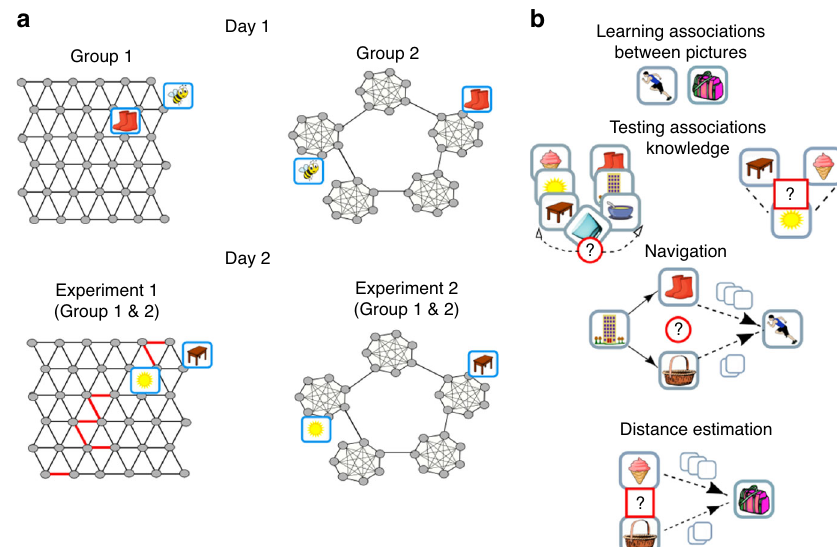
Fig. 1 Transfer of structural knowledge: graph structures and experimental design. a Experimental design. Agents and participants learned graphs with underlying Hexagonal (left) or Community (right) structure. Each grey dot is a node on a graph and corresponds to a picture that was viewed by the participant (for example, a picture of a bee). The lines are edges between nodes. Pictures of nodes that are connected by an edge can appear one after the other. The degree of all nodes in both graphs is six (a connecting node connects to one fewer node within a community to keep the degree equal to six). Participants learned the graphs during two successive days. In both experiments, participants were segregated into two groups. Participants in one group learned graphs with the same underlying structure during both days while the other groups learned graphs with different underlying structures during the different days. Two graphs were learnt during day 1 and additional graph on day 2. b One block of the task. Participants never observed the underlying graph structure but had to learn (or infer) it by performing a task. In each block, participants learned the associations between pairs of pictures, where each pair of pictures are emitted by neighbouring states on the graph. Following the learning phase, participants had to answer different types of questions: (1) report which of the two picture sequences could be extended with a target picture, (2) indicate whether the picture in the middle (sun) can appear between the two other pictures in a sequence (left and right, respectively, under ‘ Testing associations knowledge ’ ) and (3) they navigated on the graph: starting from a certain picture, for example, the building, participants had to choose (or skip) between two pictures that are connected to the current picture (the building) on the graph, for example, basket and boots (empty squares above the arrows indicate minimum steps to the target). The chosen picture then replaces the ‘ starting picture ’ . Participants repeated these steps until they reached the target picture (for instance, the running man). (4) Which picture is closer to the target picture (the bag), the ice-cream or the basket? (Distance estimation). Question type three was excluded from day 2 on experiment